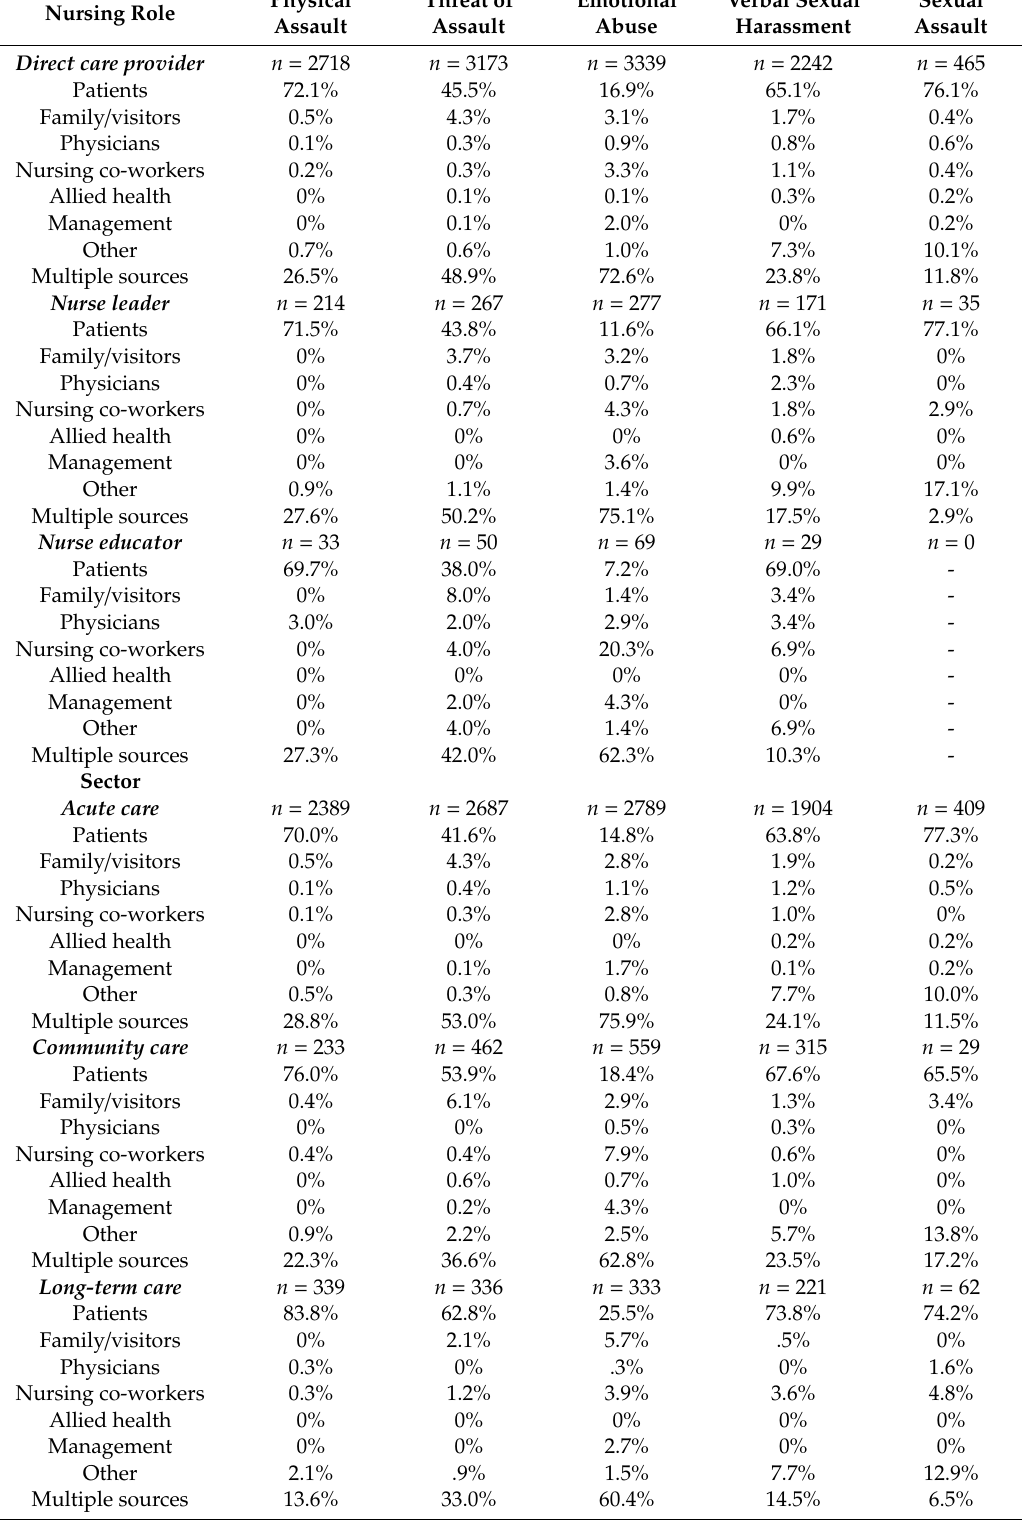
Table 4. Percentage of workplace violence that is reported compared by single and multiple sources of workplace